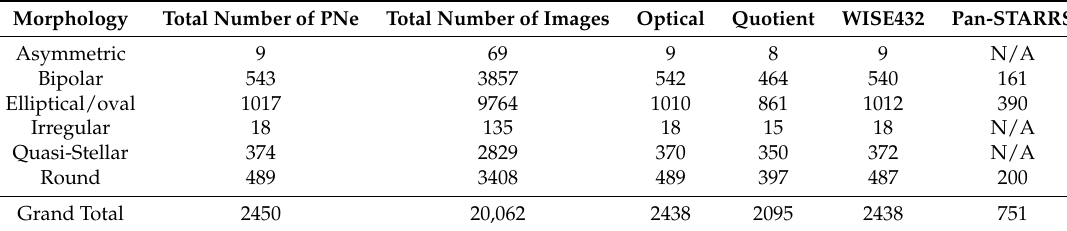
Table 3. Distribution of Morphology and the image resources from HASH DB.